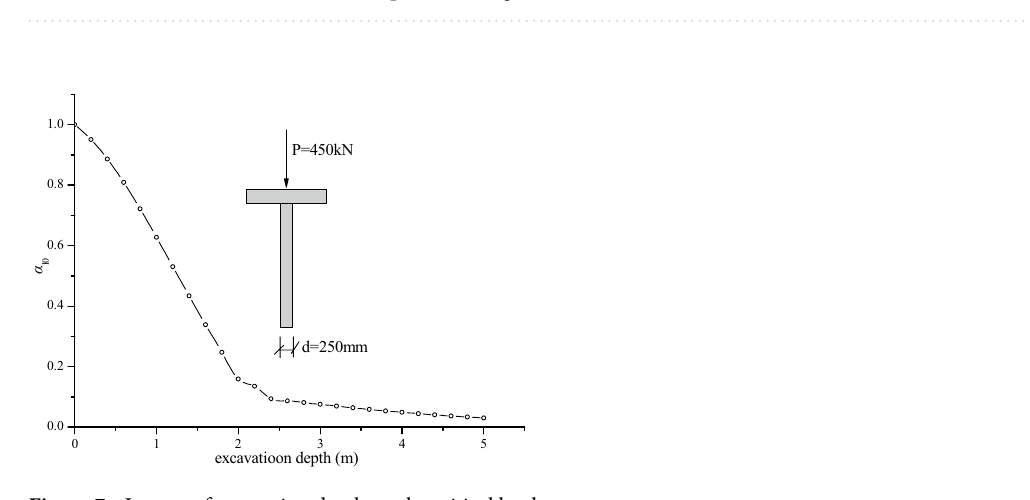
Table 2. Influences of skin friction and pile deadweight on the critical load.